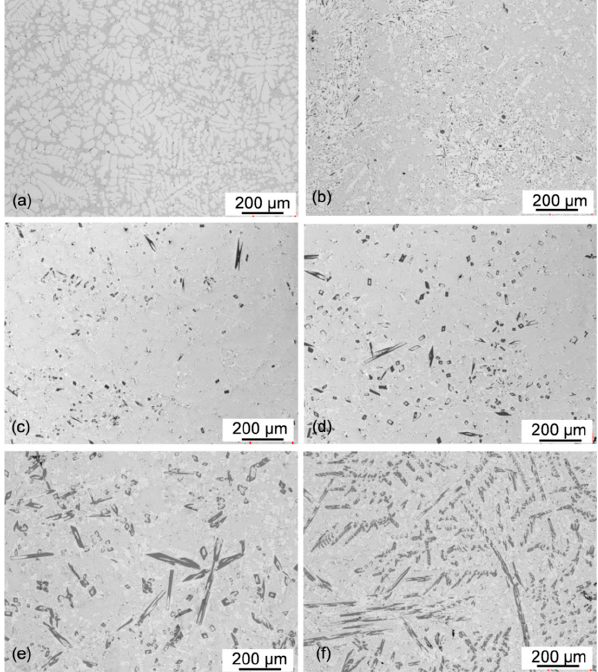
Figure 6. Optical micrographs showing the effect of chemical composition on the general microstructure of Al–Ce alloys: ( a ) Al–5Ce; ( b ) Al–10Ce; ( c ) Al–11Ce; ( d ) Al–12Ce; ( e ) Al–15Ce; and ( f ) Al–20Ce.